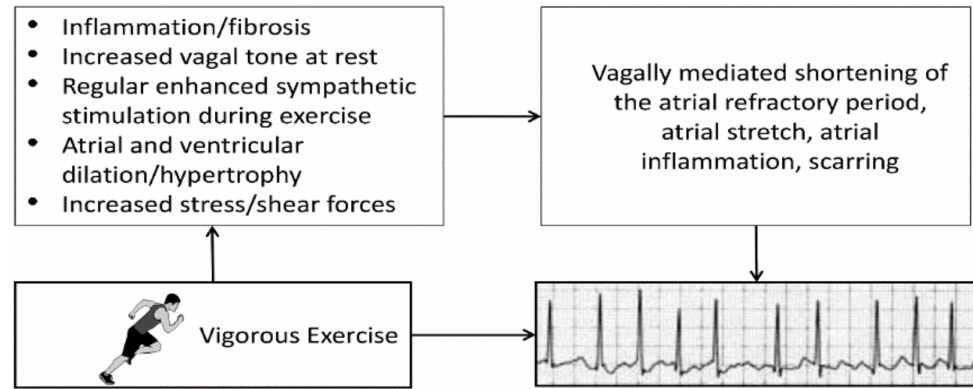
Figure 5. Potential mechanisms and associated sequelae for atrial fibrillation induced by strenuous endurance exercise. Provided with permission from the American Heart